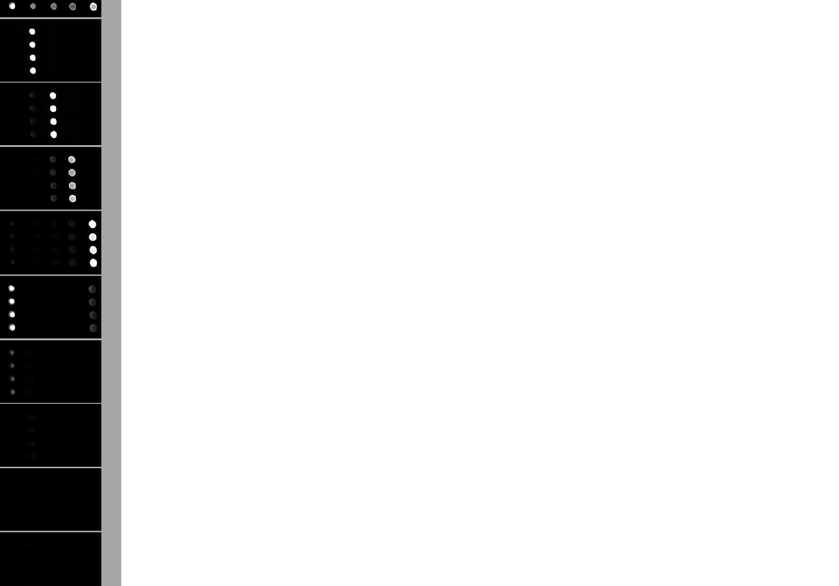
670, or 690 nm, almost only four corresponding images (four sets of C1 , C2 , C3 , C4 , C5 , C6 , C7 , C8 , or C9 ) were detected. However, some images adjacent to the four corresponding images were very faintly detected, because the transmission spectra of C1 − C9 shown in Fig. 4b slightly overlap, and each C0 of the specific wavelength has a wavelength band of 10 nm as described in Methods. These results are consistent with the transmission spectra of C1 − C9 shown in Fig. 4b and Supplementary Videos 2 and 3. In other words, the nine-color spectrometer functions as expected from the results shown in Fig. 4b. It is therefore concluded that the image-intensity profile of C1 − C9 represents the light spectrum of each C0 . Simultaneous quantification of eight dyes for four‑capillary‑array electrophoresis. The devel- oped nine-color spectrometer was applied to four-capillary-array electrophoresis (refer to Supplementary Mate- rial for details) 31,34,35 . The four-capillary array consists of four capillaries (with outer diameters of 360 μm and inner diameters of 50 μm) arranged at 1-mm intervals at laser-irradiation positions. A sample containing DNA fragments labeled with eight kinds of dyes, namely, FL-6C ( Dye1 ), JOE-6C ( Dye2 ), dR6G ( Dye3 ), TMR-6C ( Dye4 ), CXR-6C ( Dye5 ), TOM-6C ( Dye6 ), LIZ ( Dye7 ), and WEN ( Dye8 ) in ascending order of fluorescence- emission wavelength, was separated in each of the four capillaries (hereafter, Cap1 , Cap2 , Cap3 , and Cap4 ). Laser-induced fluorescences from Cap1 − Cap4 were collimated by the four-lens array and simultaneously detected by the nine-color spectrometer. Time courses of nine-color ( C1 − C9 ) fluorescence intensities during electrophoresis, i.e., a nine-color electropherogram for each capillary, are shown in Fig. 7a. Equivalent nine- color electropherograms were obtained in Cap1 − Cap4 . As indicated by the arrows in Fig. 7a for Cap1 , eight peaks in each nine-color electropherogram respectively show individual fluorescence emissions of Dye1 − Dye8 . Intensity distributions of C1 − C9 at the eight peaks are respectively shown in Fig. 7b. Since C1 − C9 and Dye1 − Dye8 are both in wavelength order, the eight distributions in Fig. 7b show fluorescence spectra of Dye1 − Dye8 in order from left to right. In this study, Dye1 , Dye2 , Dye3 , Dye4 , Dye5 , Dye6 , Dye7 , and Dye8 are shown in magenta, purple, blue, cyan, green, yellow, orange, and red, respectively. Note that the colors of the arrows in Fig. 7a correspond to the colors of the dyes in Fig. 7b. Fluorescence intensities of C1 − C9 for each spectrum in Fig. 7b are normalized so that their summation is one. Eight equivalent fluorescence spectra are obtained by Cap1 − Cap4 . Fluorescence spectral overlaps between Dye1 − Dye8 are clearly observed. As shown in Fig. 7c, for each capillary, the nine-color electropherogram in Fig. 7a was converted to an eight-dye electropherogram by multicomponent analysis 31 based on the eight fluorescence spectra in Fig. 7b (refer to Supplementary Material for details). Since the fluorescence spectral overlaps in Fig. 7a do not appear in Fig. 7c, it is possible to individually identify and quantify Dye1 − Dye8 at each time point even if different quanti- ties of Dye1 − Dye8 emit fluorescences simultaneously. That would not be possible by conventional seven-color detection 31 ; however, it is possible by the developed nine-color detection. As indicated by arrows in Fig. 7c for